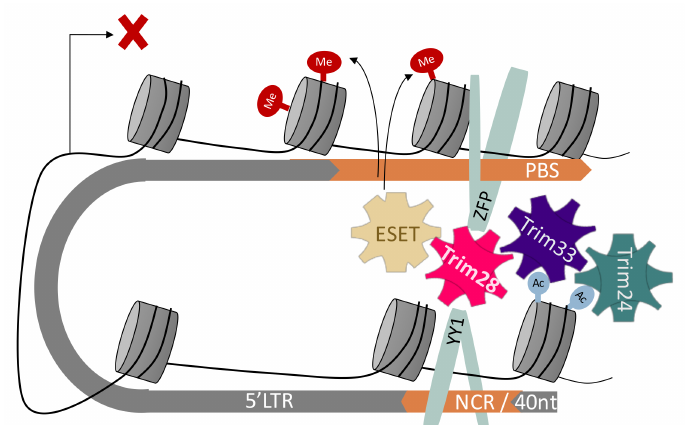
Figure 5. Model for Tif1 family members’ complex formation. A suggested interpretation of the data, showing binding of Trim24 and Trim33 to areas distal from the transcription start site and the PBS. By modifying the 3D structure of the provirus, the complex can be formed or collapse in a dynamic